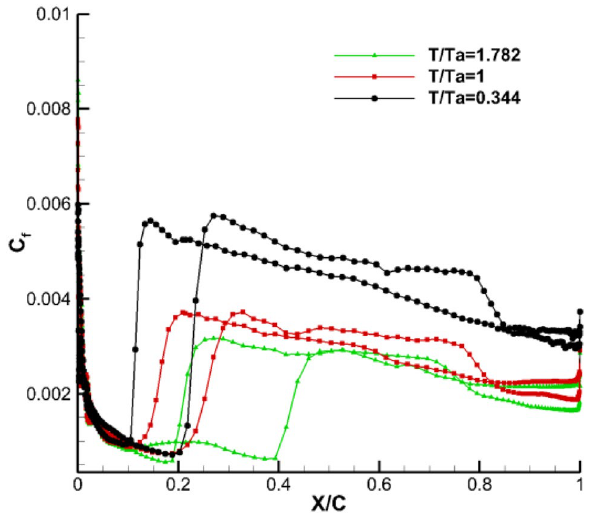
Figure 13. Evolution of friction coefficient, wing section (z = 0.175) at design point (M = 0.9, α = 2.0°).